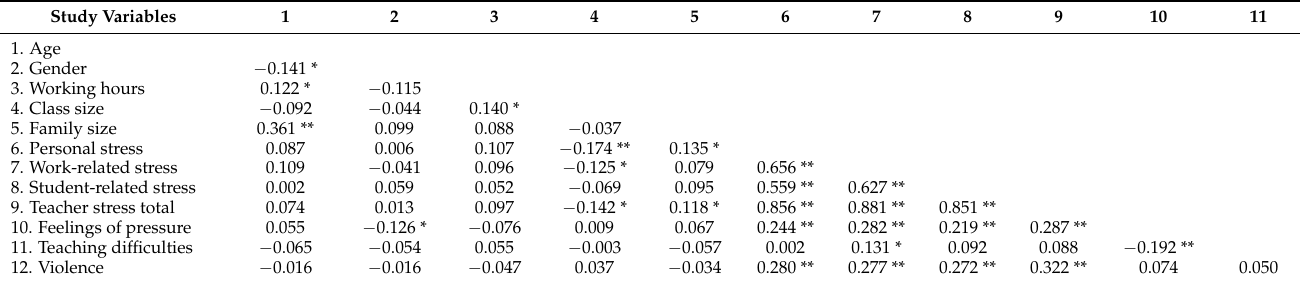
Table 3. Correlation among demographics, burnout, burden, and satisfaction of